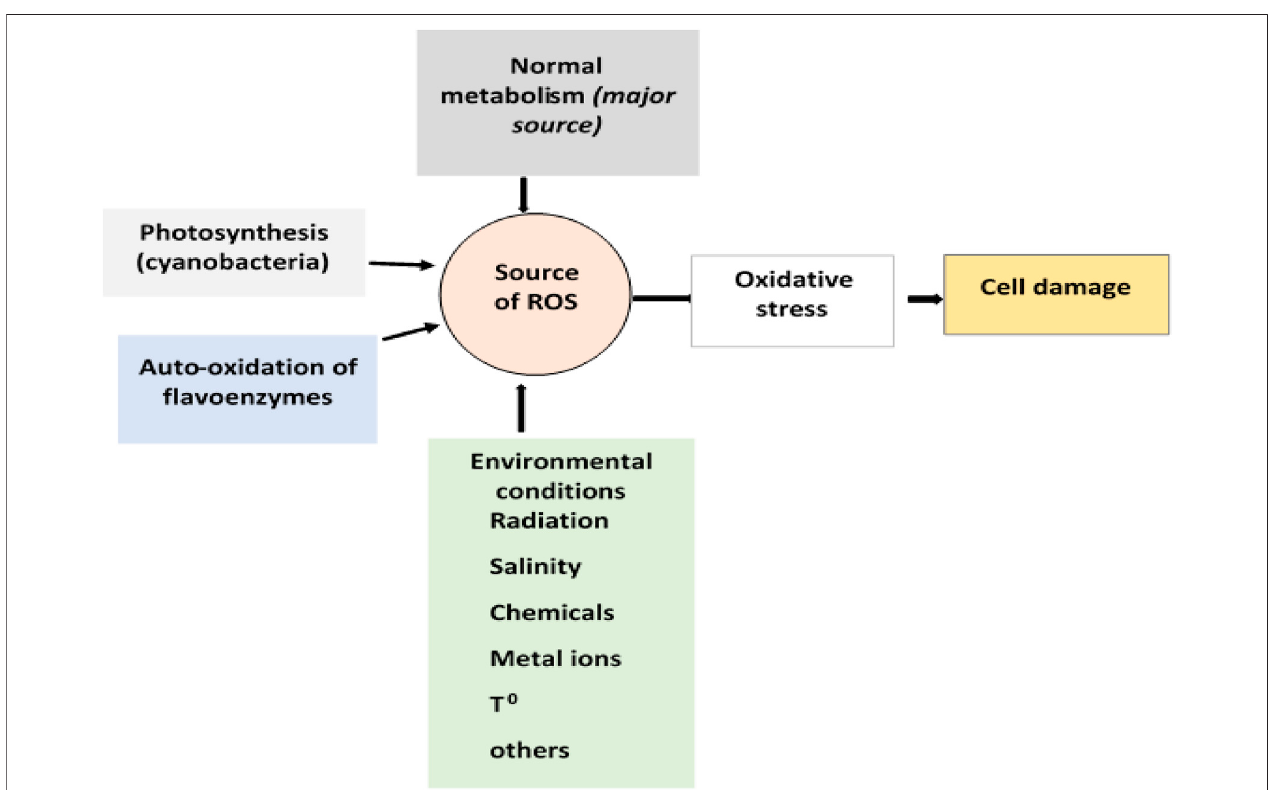
FIGURE 3 | Sources of oxidative stress and its effect on